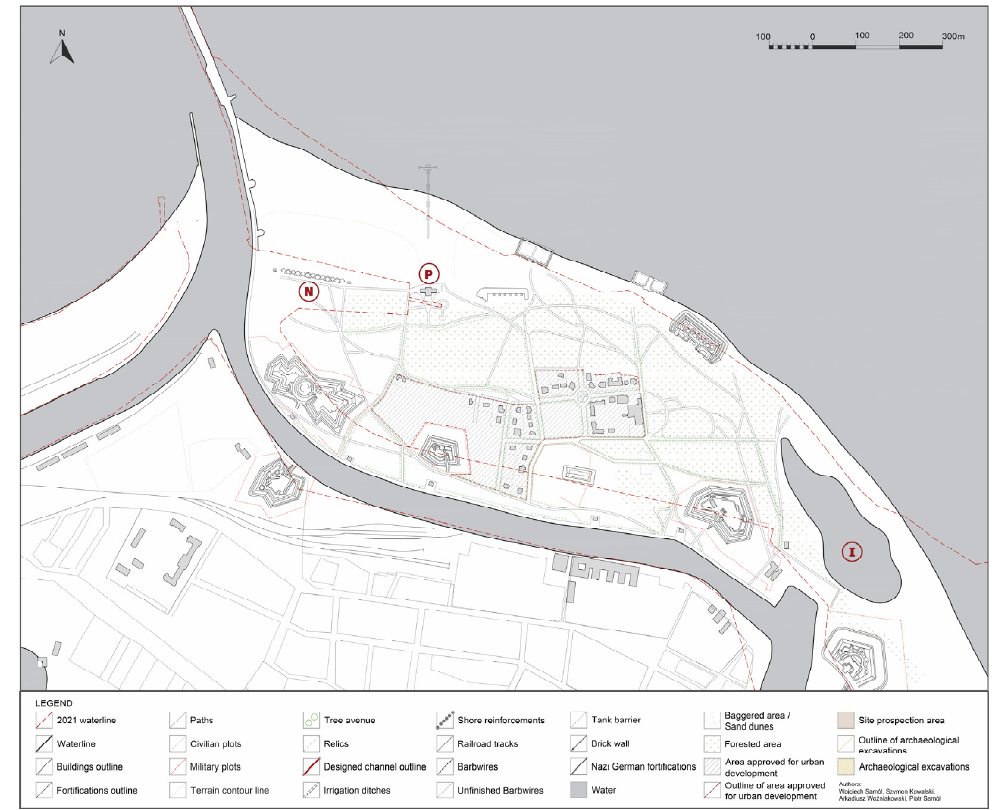
Figure 8. Westerplatte during extensive urban development with summer villas and an SPA resort (in